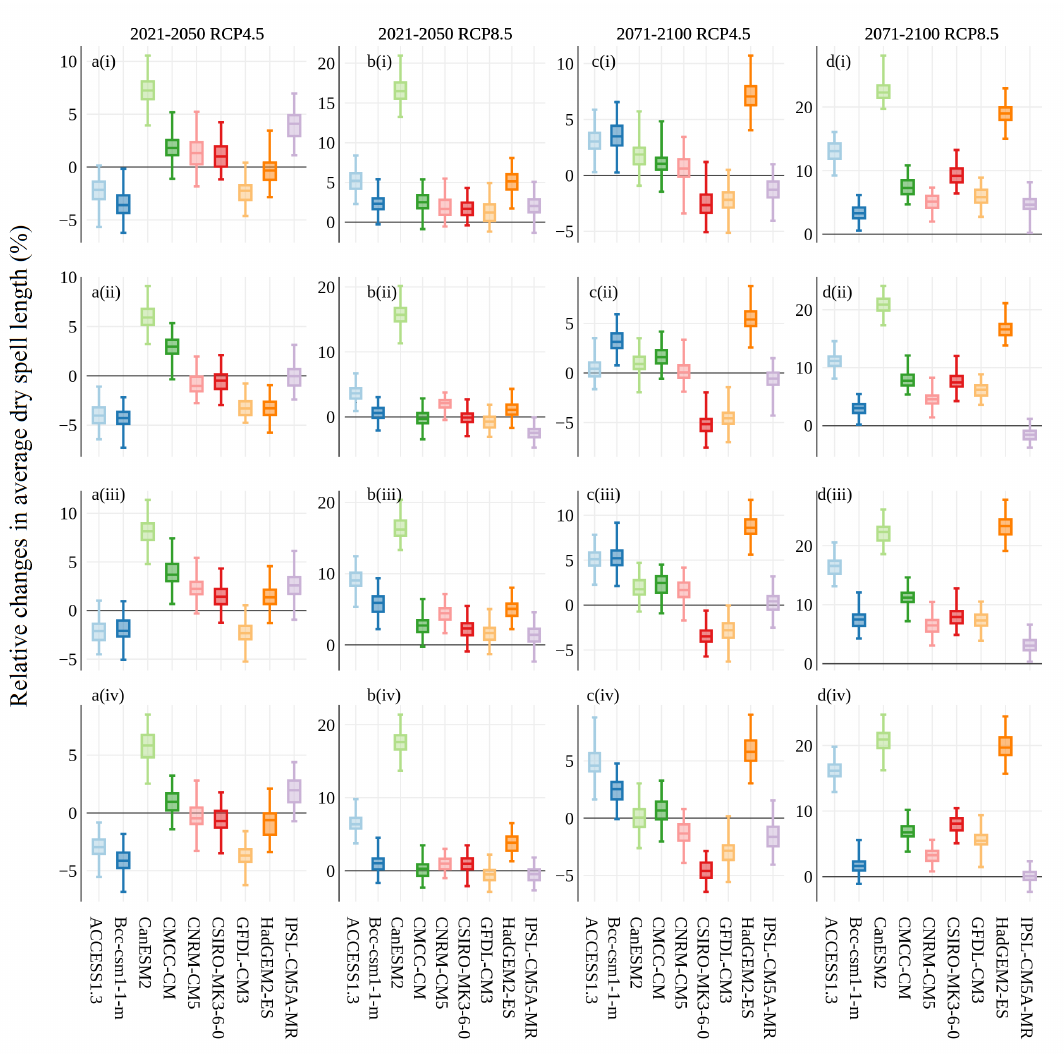
Figure 10. Relative changes (%) in average dry spell lengths from downscaled GCM data for: ( a ) 2021–2050 period under RCP4.5 scenario; ( b ) 2021–2050 period under RCP8.5 scenario; ( c ) 2071–2100 period under RCP4.5 scenario; and ( d ) 2071–2100 period under RCP8.5 scenario relative to